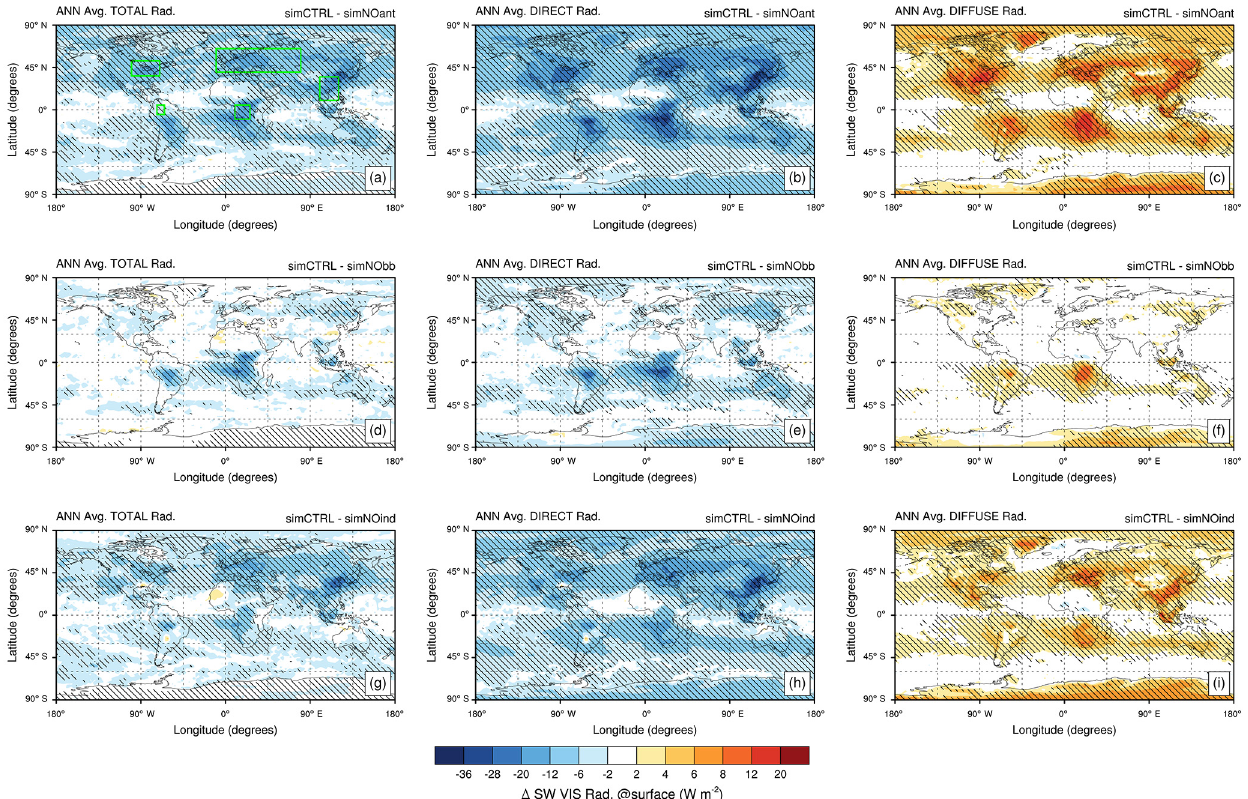
Figure 4. Spatial distribution of annual absolute change in shortwave visible (SW VIS) (a, d, g) total, (b, e, h) direct, and (c, f, i) diffuse solar radiation (in Wm − 2 ). Changes are computed between the control experiment (SimCTRL) and sensitivity experiments: (a–c) without all anthropogenic emissions (SimNOant); (d–f) without biomass burning emissions (SimNObb); and (g–i) without anthropogenic emissions except biomass burning (SimNOind). All experiments are set in a present-day climatic state. Shaded regions indicate areas where changes in solar radiation are significant at the 95% confidence level. Green boxes on plot (a) highlight key regions selected for